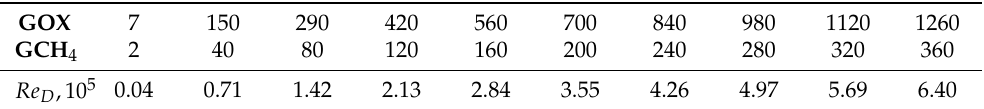
Table 1. Average mass flow rate values to test, in